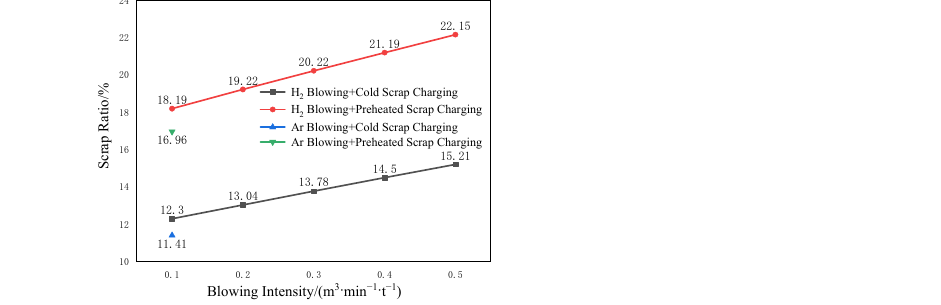
Figure 4. Influence of hydrogen injection intensity and scrap preheating on scrap/hot metal ratio in converter smelting.